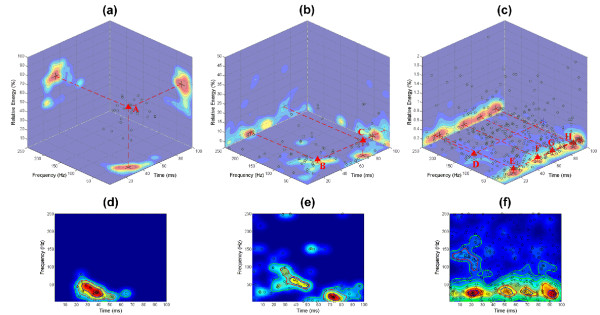
Distributions of SEP t-f components. (a)-(c) Distributions of high-energy, middle-energy, and low-energy t-f components in time-frequency-energy space. (d)-(f) Distributions of high-energy, middle-energy, and low-energy t-f components in time-frequency space and peak regions under different values of region threshold. The projections of 3D distributions on time-frequency/time-energy/frequency-energy domains are also illustrated in (a)-(c). The black circles denote the t-f components, and the red triangles indicate the clusters. The blue, red, green lines in (d)-(f) indicate the peak regions when ξ = 0.75, 0.5, and 0.25, respectively.